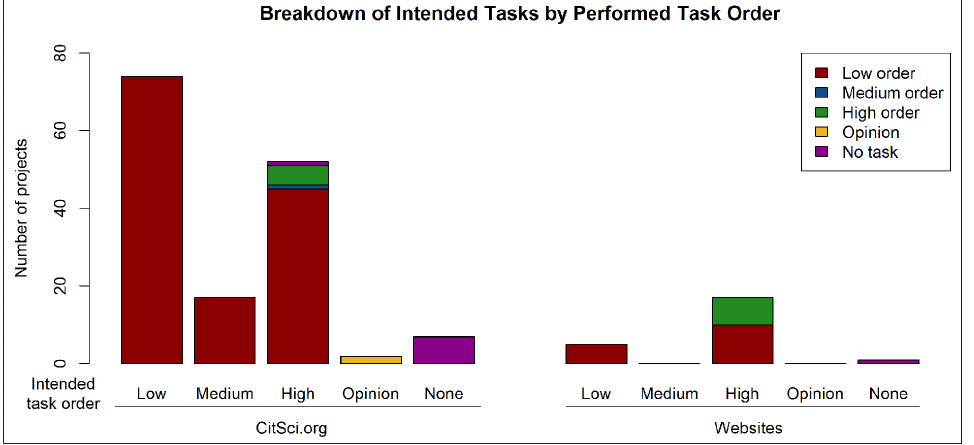
Figure 3: Breakdown of intended tasks by performed task order. Misalignment of intended and performed tasks expected of citizen science